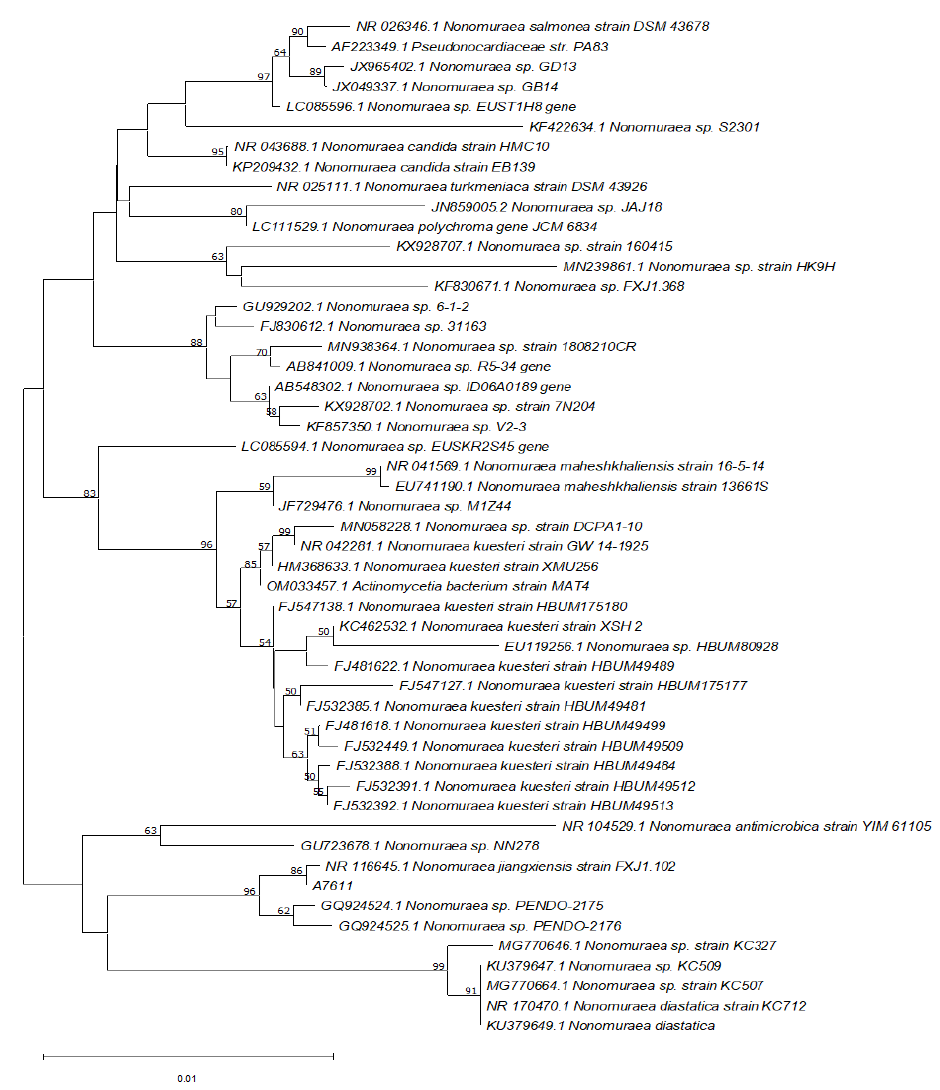
Figure 6. Phylogenetic tree showing the evolutionary relationship between A7611 and other type species of the genus Nonomuraea . Neighbor-joining phylogenetic tree was constructed based on 16S rRNA gene sequence showing the relationship between isolated strain A7611 and representatives or related actinobacteria strains retrieved from the GenBank with their respective accession numbers. Bootstrap values greater than 50% are shown at the number on the branches nodes which were analysed based on 1000 replicates. Bar, 0.01 substitutions per nucleotide position.